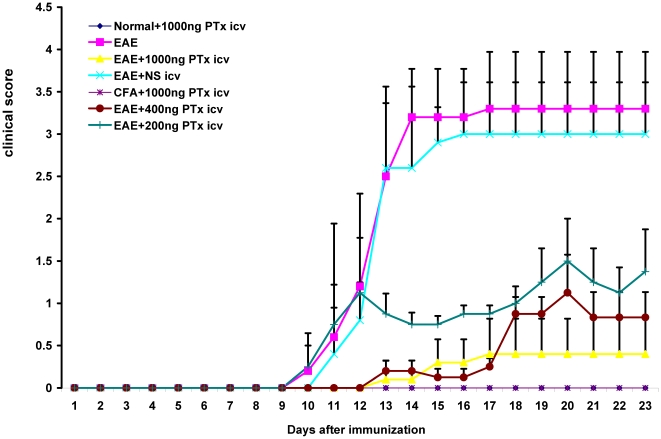
EAE +PTx icv mice developed an attenuated and delayed course of EAE.Clinical scores were evaluated daily in EAE +PTx icv and control mice and were plotted as the mean ± S.D (n = 12/group). Maximum clinical scores as well as scores on day 14 and 23 evidence marked attenuation of disease severity after PTx icv (P<0.01). A dose response to PTx icv is demonstrated as well. Mice receiving lower doses of PTx icv (400 ng and 200 ng) continued to manifest a dose dependent benefit compared to the EAE controls (P<0.05).